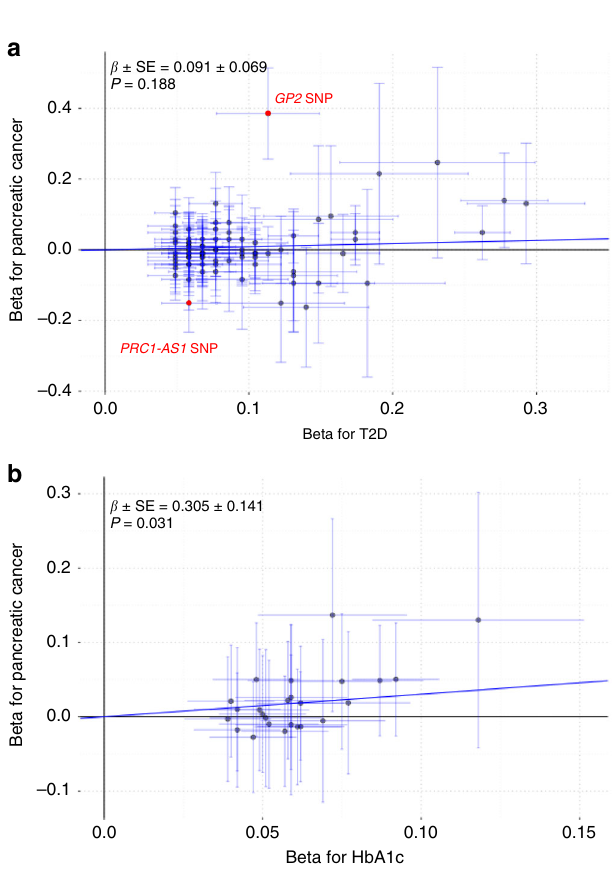
Fig. 5 Mendelian randomization analysis for the T2D – pancreatic cancer associations. a The results from 82 type 2 diabetes (T2D)-associated SNPs. Red dots indicate the outlying SNPs detected by MR-PRESSO. Beta values represent the log odds ratio (OR) of T2D or pancreatic cancer per risk allele copy for each SNP. b Twenty- fi ve HbA1c-associated SNPs. Beta values represent the change in the rank-based inverse normal transformed values of the HbA1c level per risk allele copy for each SNP. MR Mendelian randomization, T2D type 2 diabetes, MR-PRESSO Mendelian Randomization Pleiotropy RESidual Sum and Outlier, HbA1c hemoglobin